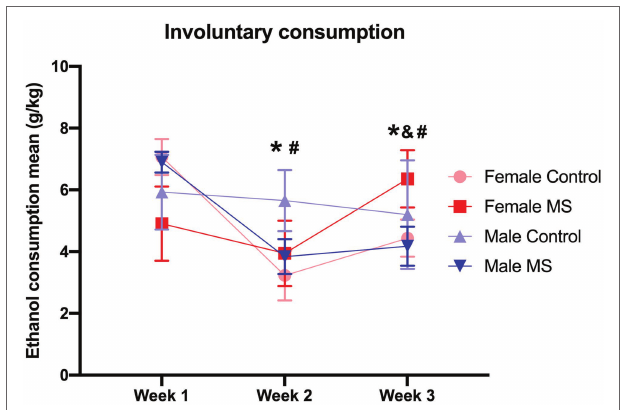
FIGURE 2 | Involuntary consumption. Means of 20% ethanol consumption of female and male mice submitted to maternal separation (MS) and control group, during weeks 1, 2, and 3. N = 28 (Control: n = 14; female = 7, male = 7, MS: n = 14; female = 7, male = 7). Linear mixed model (LMM) analysis, data: mean ± SEM. * p < 0.05 female control group in weeks 2 and 3 compared to week 1; & p < 0.05 female MS group in week 3 compared to week 2; # p < 0.05 male MS group in weeks 2 and 3 compared to week